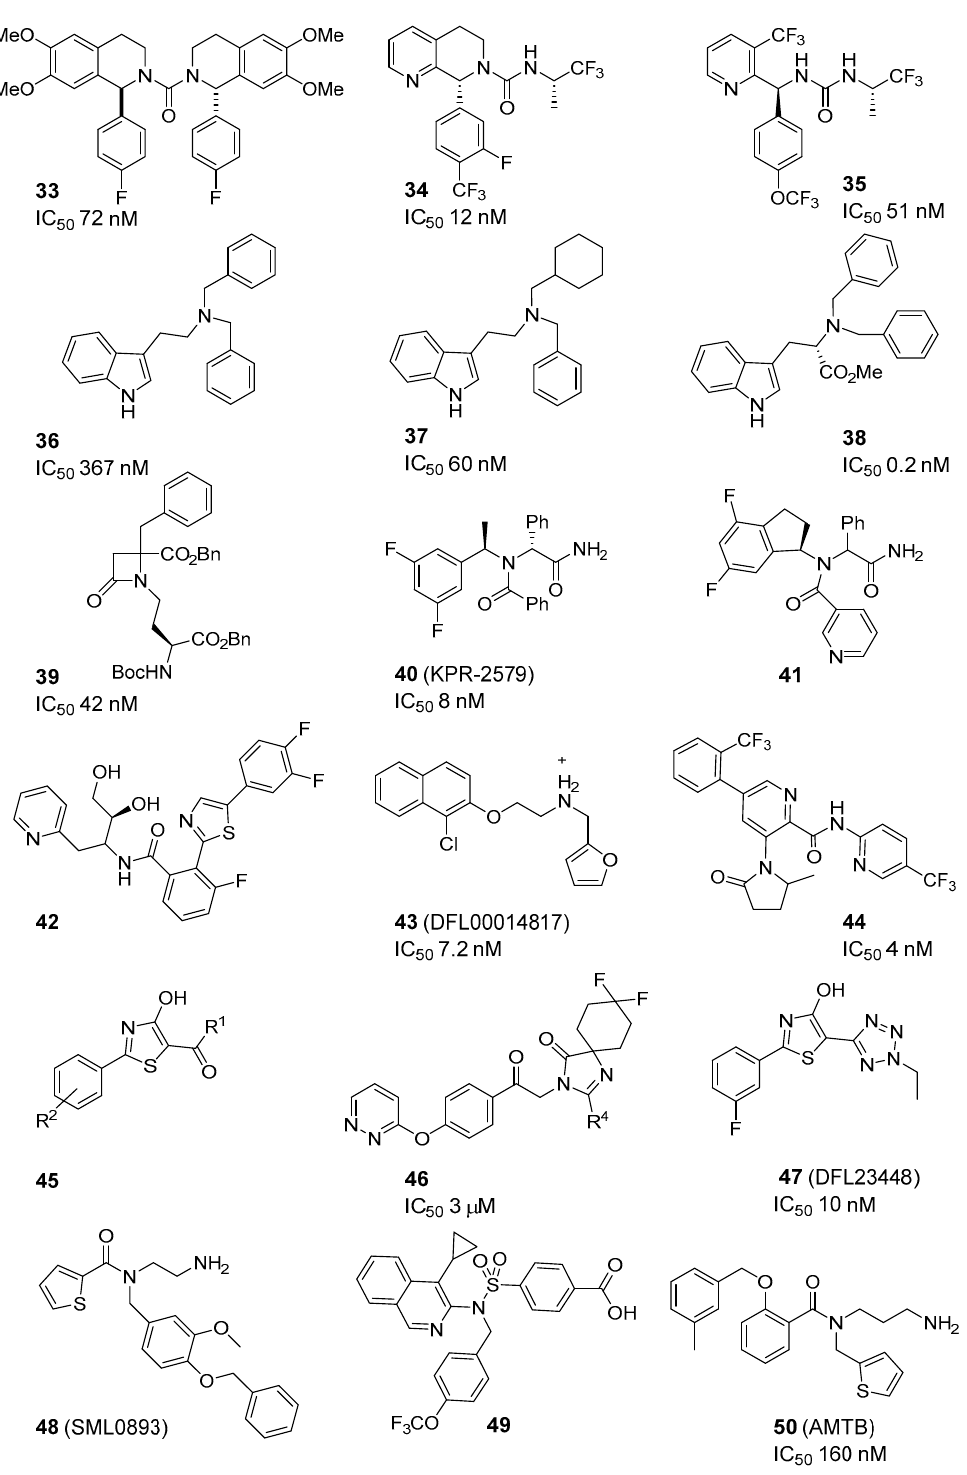
Figure 4. Lately described TRPM8 antagonists.